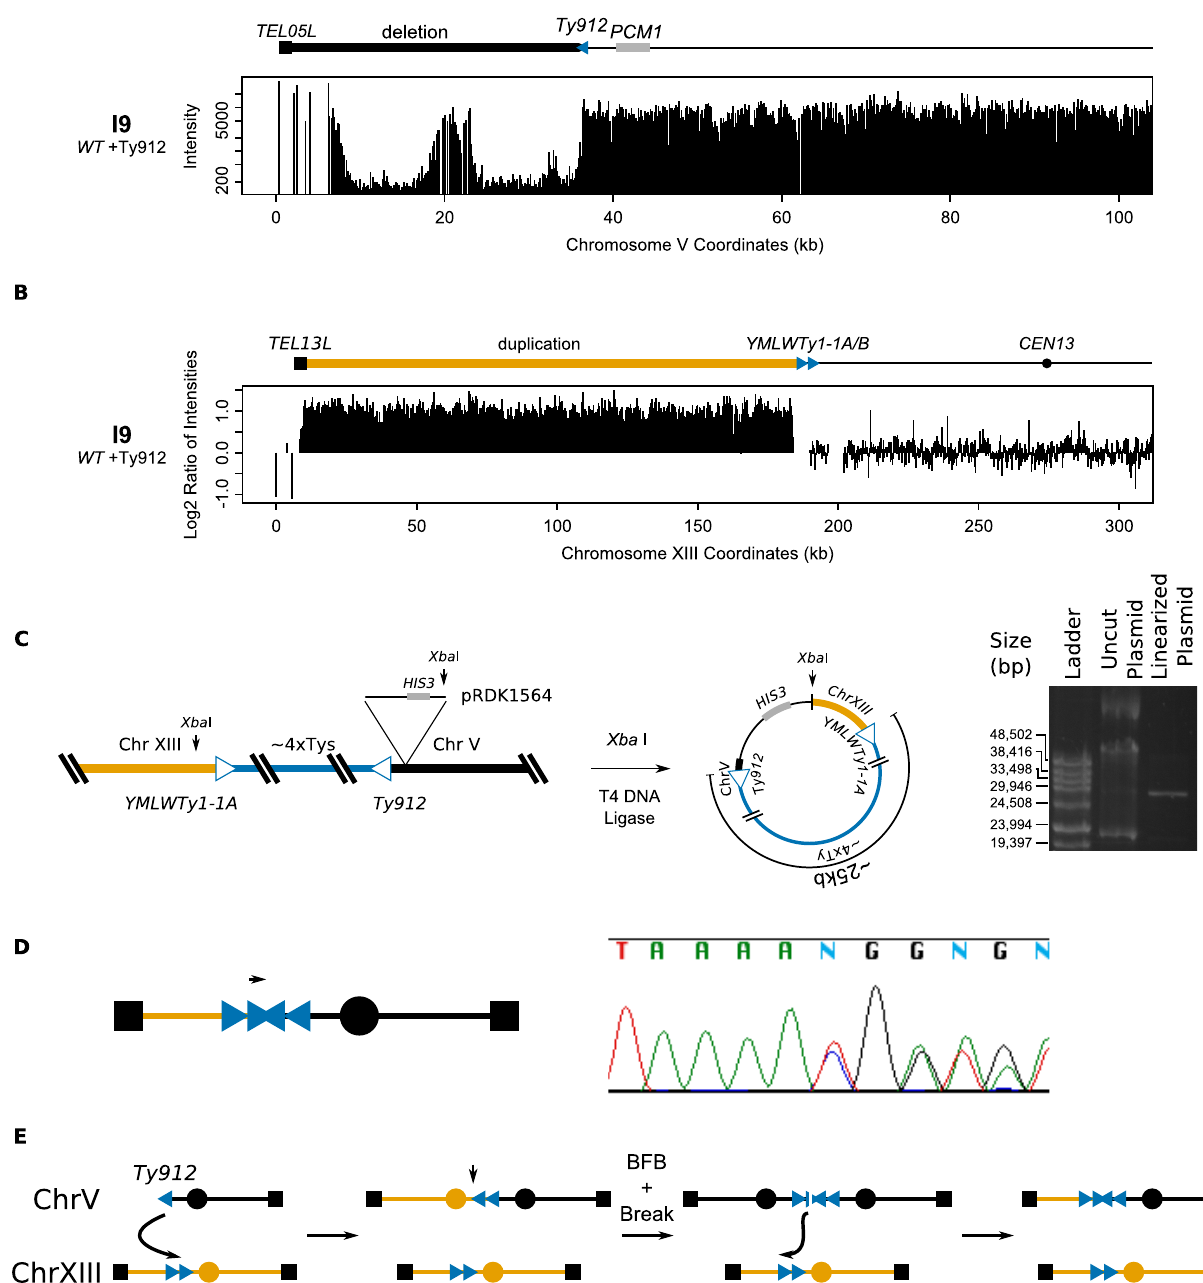
Figure 3. Analysis of isolate I9 reveals a structure consistent with breakage-fusion-bridge. A. Deletion of the region between TEL05L and Ty912 in isolate I9. B. Duplication of the genomic region between TEL13L and YMLWTy1-1A/B . The duplicated region is located upstream of the 5 9 end of YMLWTy1-1A/B as indicated. C. Schematic of the integration of pRDK1564 near the fusion junction and the subsequent steps utilized to create a vector cloning the fusion junction. The linearized form of the vector measures approximately 30 kb; 25 kb of the cloned fusion vector is predicted to be Ty DNA. D. Internal primer hybridizing within the epsilon sequence of the Ty reveals a heterogeneous chromatogram, indicating presence of at least two unique Ty sequences. E. A proposed mechanism for the creation of the observed structure. Exposed Ty912 sequence invades YMLWTy1-1A , resulting in a dicentric chromosome. Formation of the dicentric results in one round of breakage-fusion-bridge (with the break at the vertical arrow) followed by a subsequent break due to the formation of a second dicentric. The new break invades a wild type copy of chromosome XIII at YMLWTy1- 1A/B resulting in the observed duplication and correctly sized fusion junction.